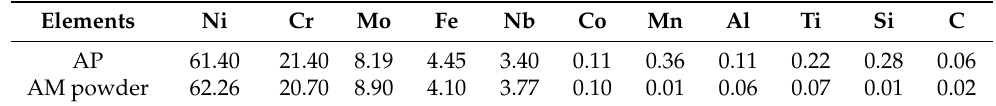
Table 1. Chemical composition of AP plate and 3DPP powder